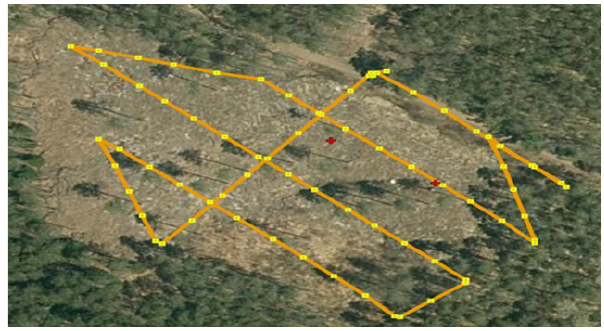
Figure 5: DJI matrice 100